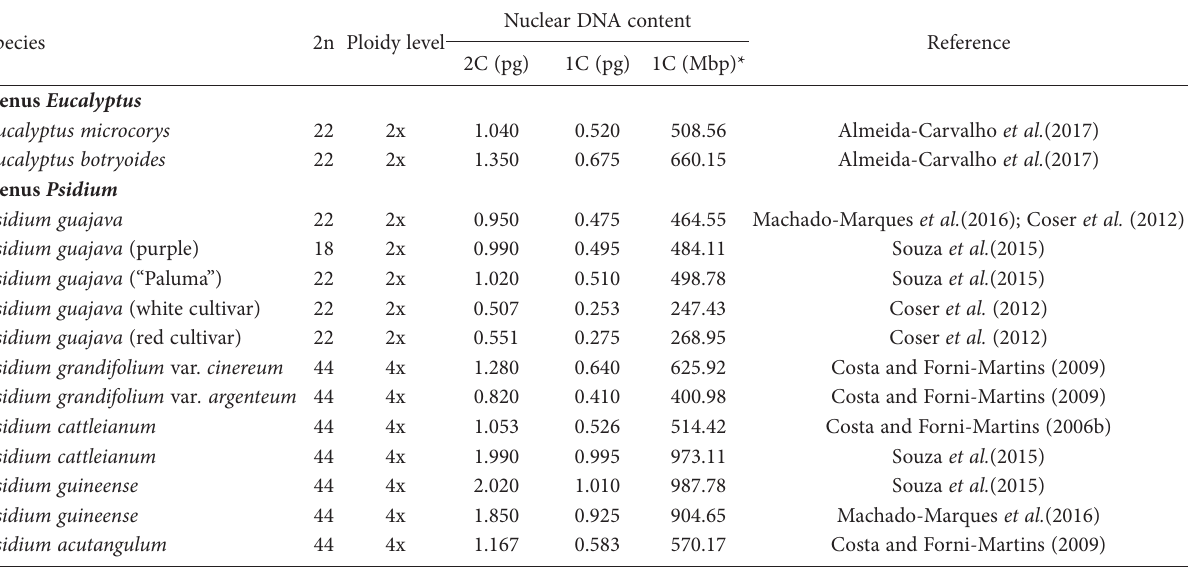
Table 1. Chromosomes number and genome size from different species of Psidium and Eucalyptus (Myrtaceae) determined in previous studies. The content of holoploid nuclear DNA (2C, pg DNA) and the content of monoploid DNA (1C, pg DNA) are also provided.